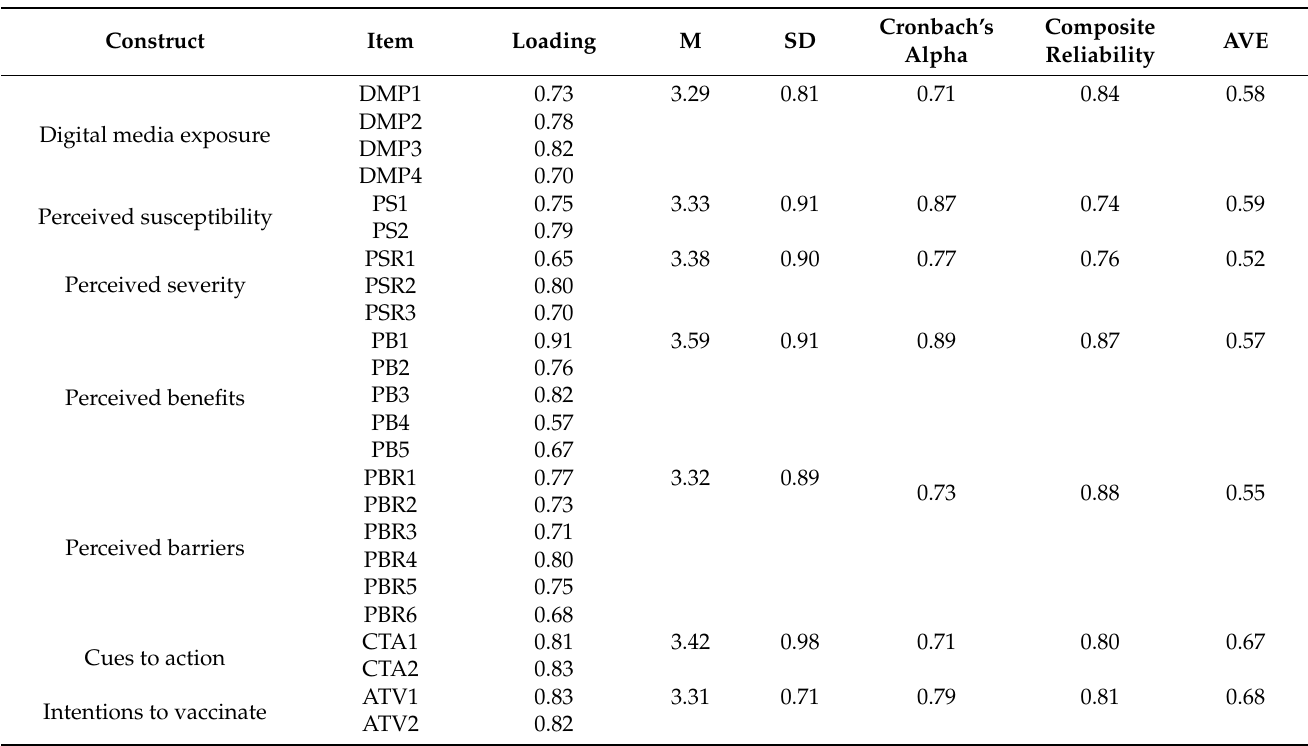
Table 2. Factor Load Analysis & Reliability and Validity